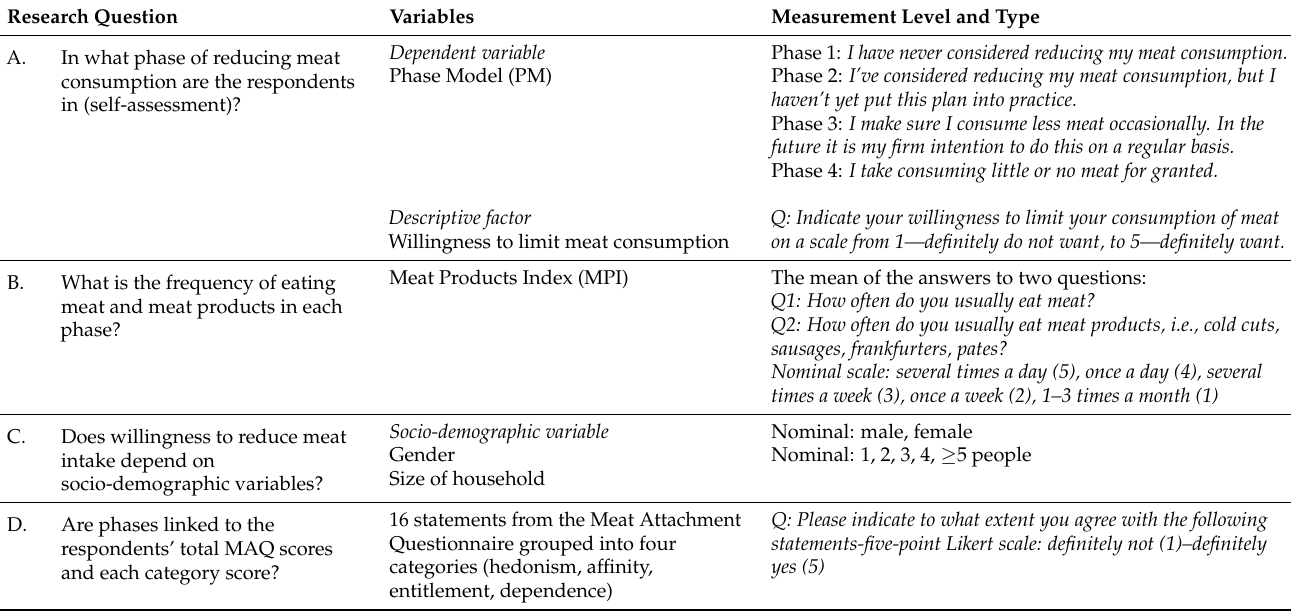
Table 1. Operationalization of research questions: survey questions and